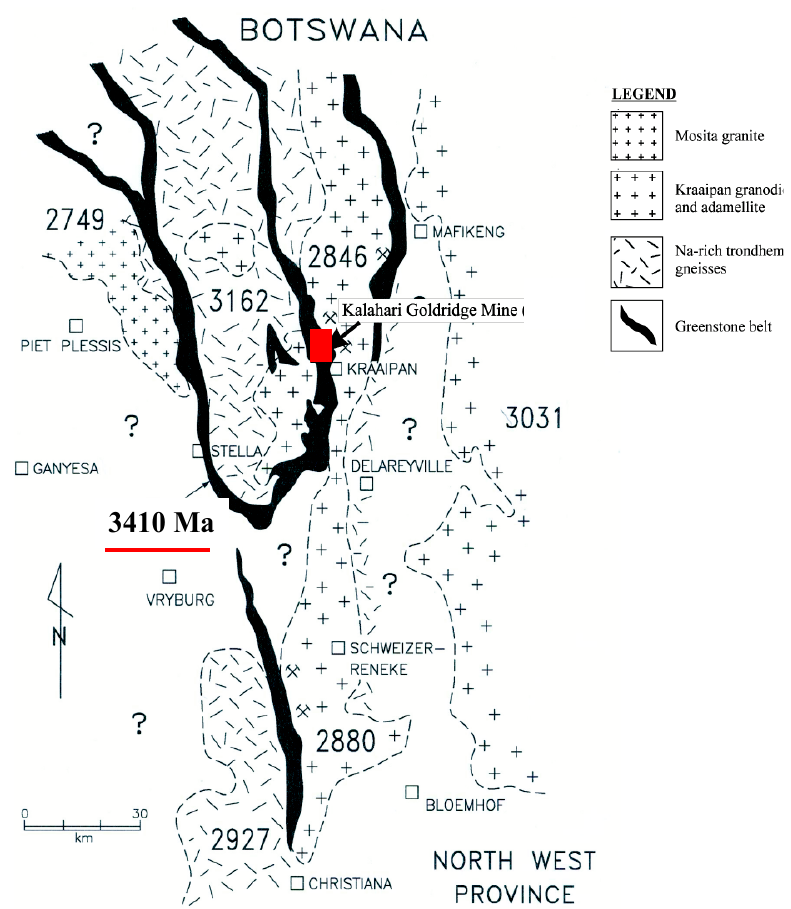
Figure 2. Simplified geologic map of the Kraaipan terrane [35], showing the locality of the Kalahari mine. Numbers indicate approximate ages (Ma) of BIFs and related rocks.